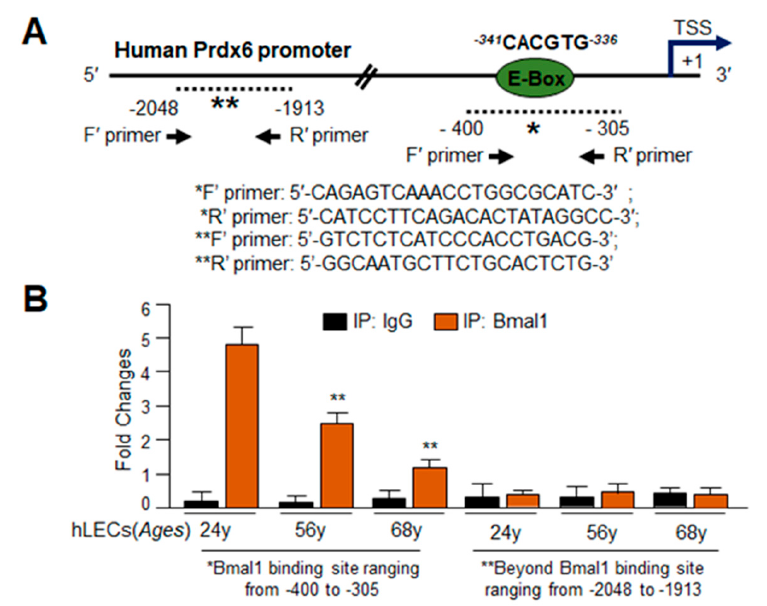
Figure 4. Proximal promoter of human Prdx6 gene had active Bmal1 / E-Box responsive elements. ( A ) Panel showing illustration of 5‘-proximal promoter of Prdx6 gene displaying Bmal1 responsive sequences, E-Box element, and position of the Chromatin Immunoprecipitation (ChIP) primers